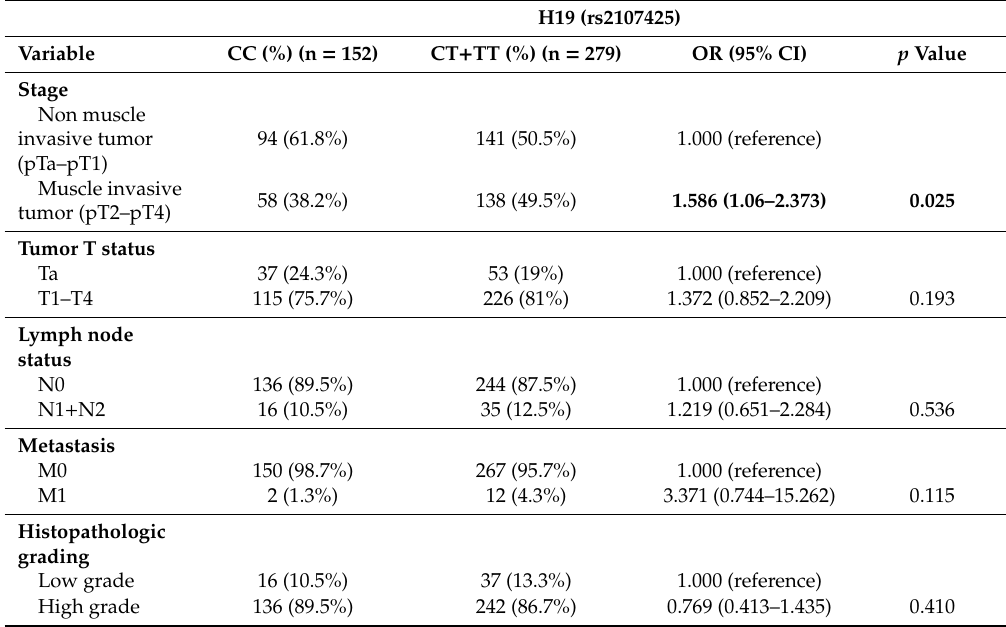
Table 4. Distribution frequency of the clinical status and H19 rs2107425 genotype frequencies in 431 UCC